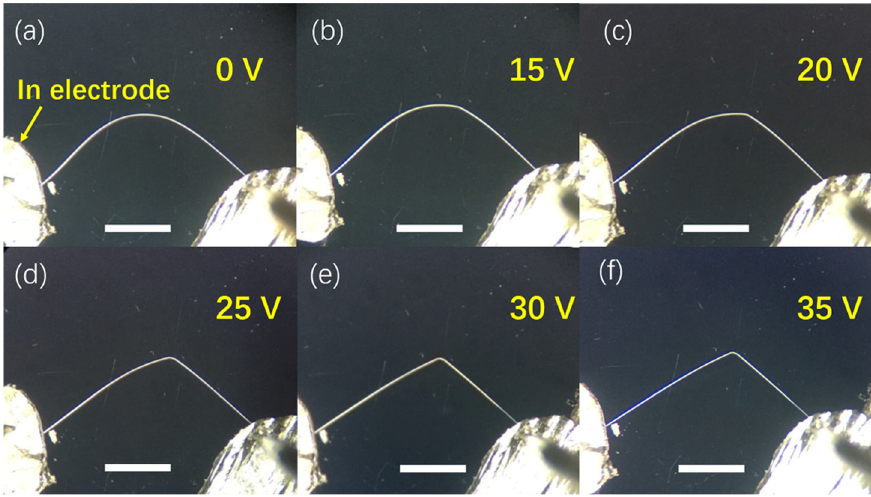
Figure 1. Optical images of the bending ZnO microwire with increasing the applied voltages (from 0 V to 35 V, in ( a – f ) respectively). (scale bar: 3 mm).